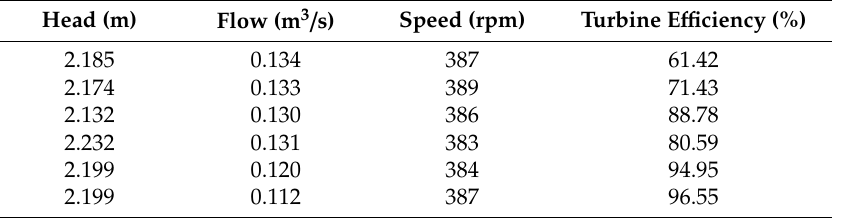
Table 6. E ffi ciency measurement at reduced head and reduced speed.